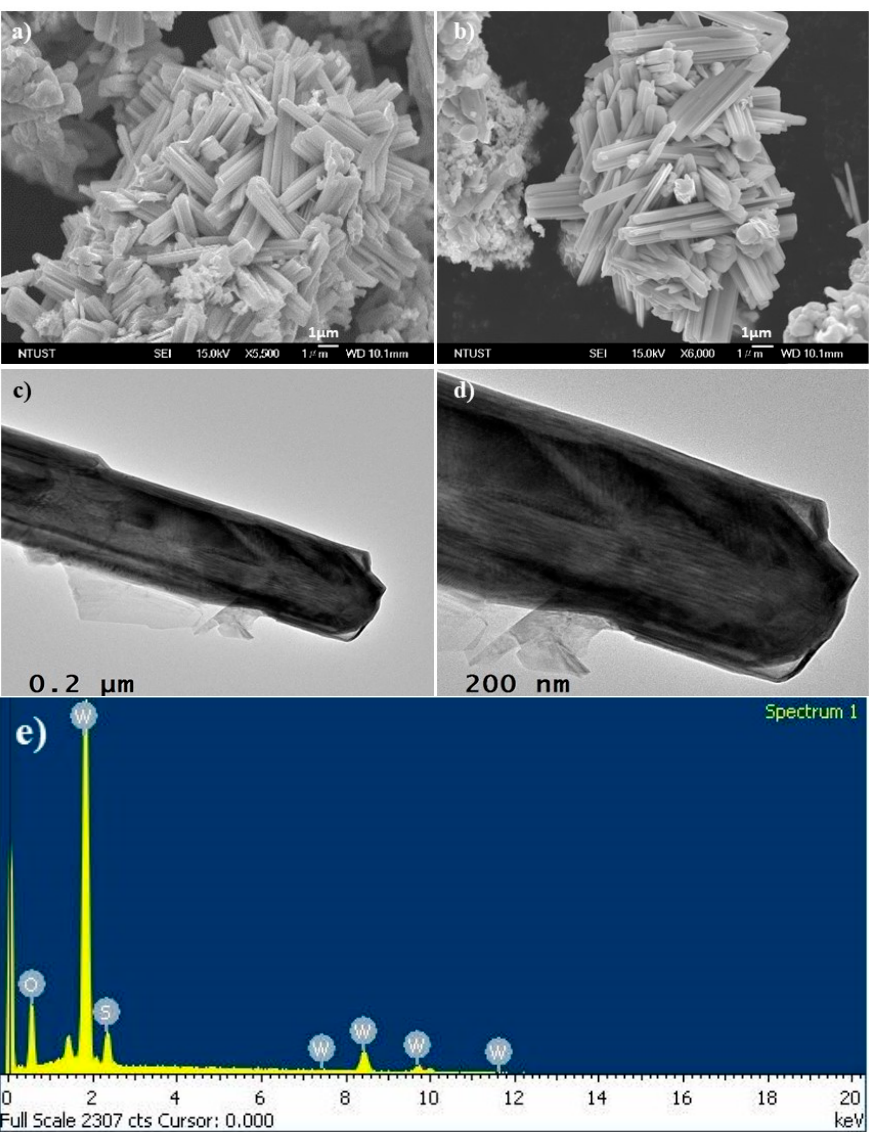
Figure 1. ( a , b ) FE-SEM images for the WS 2 nanotubes, ( c , d ) TEM images of the synthesized WS 2 nanotubes, and ( e ) EDS results for WS 2 nanotubes .